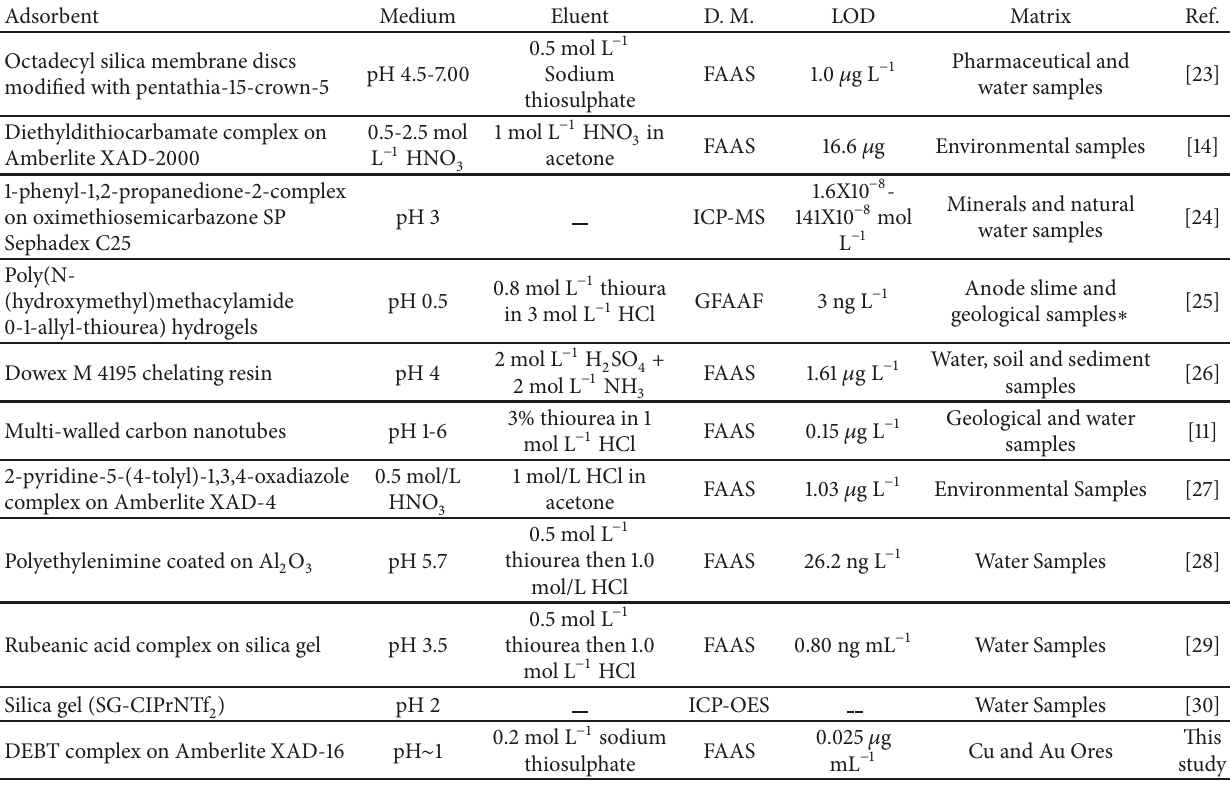
Table 4: Comparison of the proposed method with some studies based on SPE and determination of gold reported in literature.